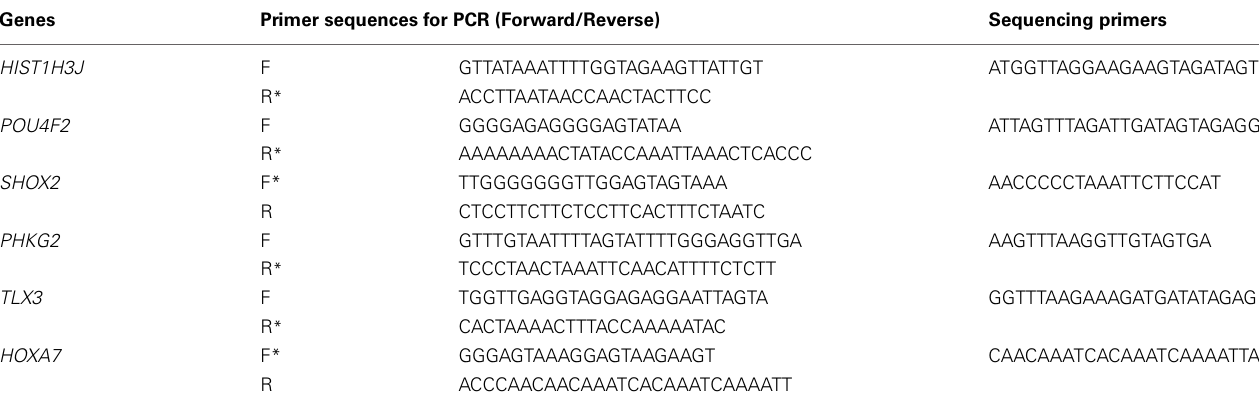
Table 1 | Primer sequences for pyrosequencing of six potential methylation biomarkers.